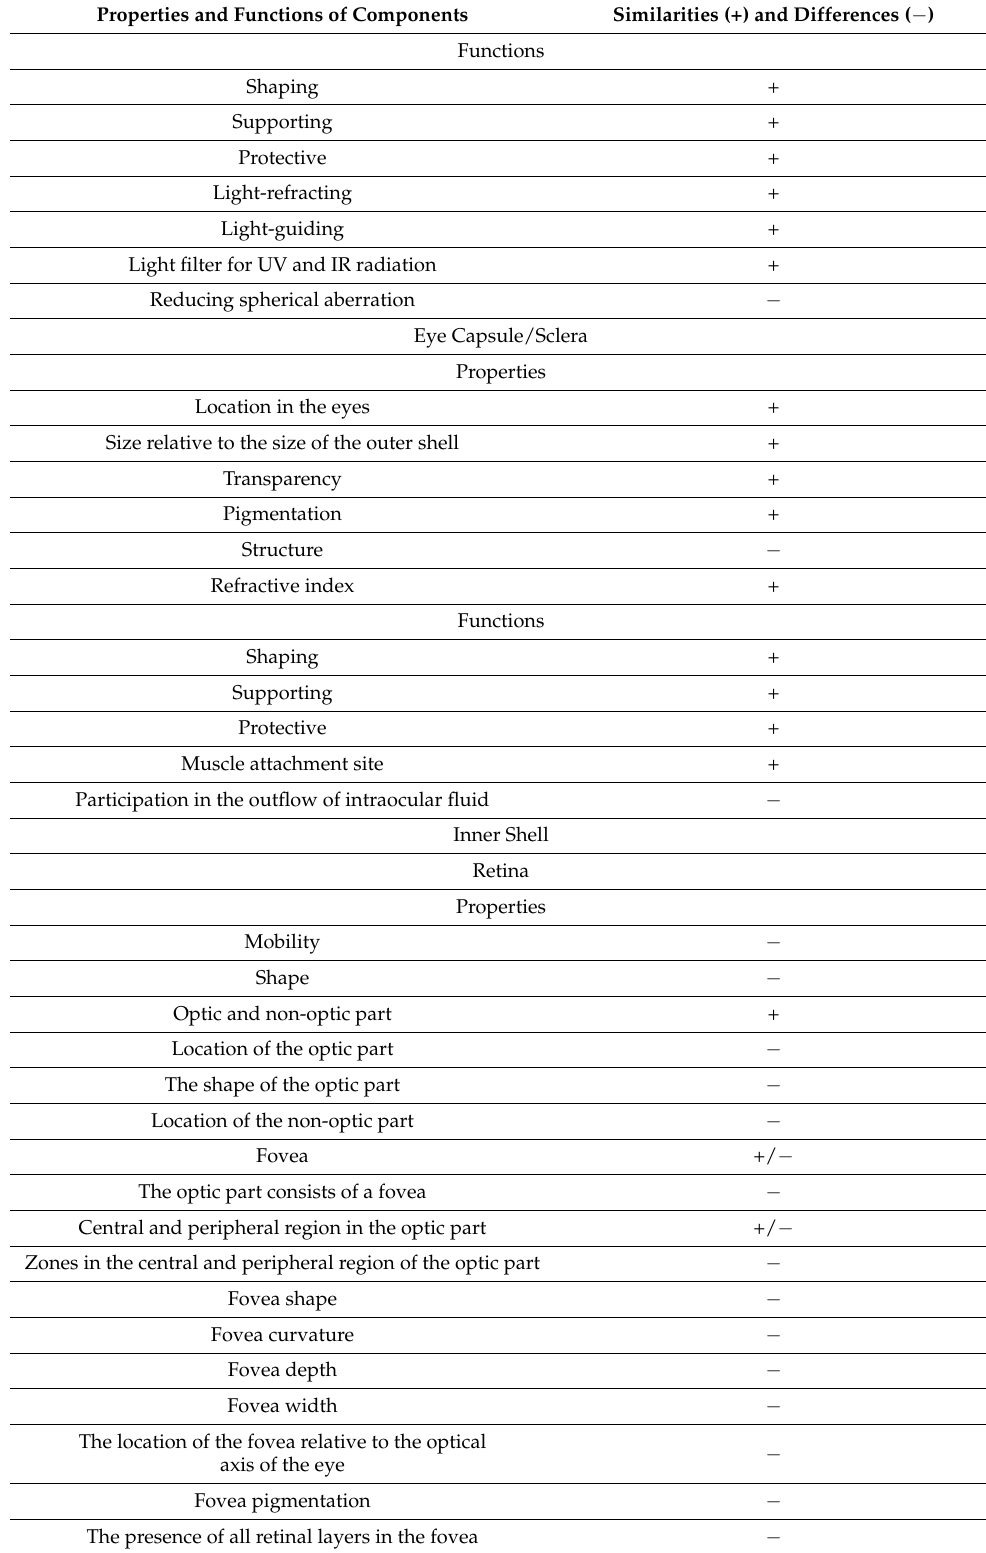
Table 1. Cont. Properties and Functions of Components Similarities (+) and Differences ( − )